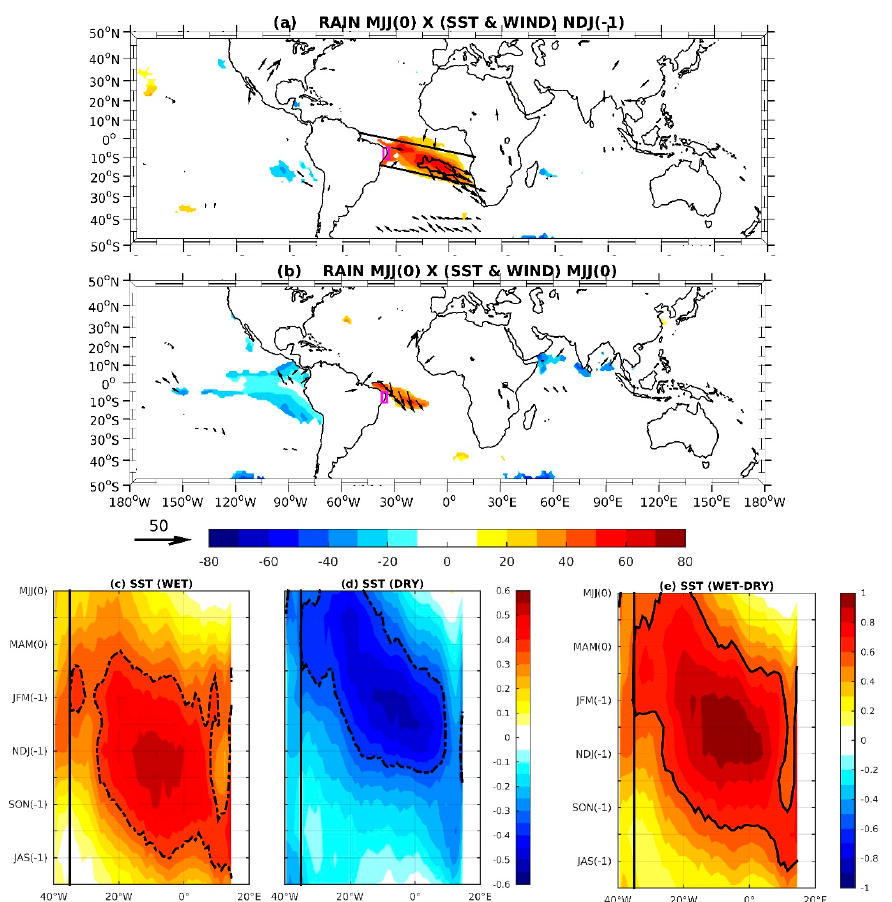
Figure 2. Distributions of the lagged linear correlation/regression (mm month -1 /°C) of the gridded SST (from OAFlux) anomalies in ( a ) November-December-January(-1) (NDJ( − 1)) and ( b ) MJJ(0) with the rainfall anomalies in Eastern NEB (magenta box) during MJJ(0) for the period 1960–2015. The vectors represent the linear regression (mm month − 1 /m s − 1 ) of the surface wind vectors (u and v; from NCEP) anomalies, with the rainfall anomalies in Eastern NEB. The correlations that are significant at the 95% confidence level, according to the t -test, are plotted for both SST and wind. Contours indicate regions of correlation higher than +0.5 (solid black line) for SSTA. The diagonal band in Figure 2a indicates the pathway of the northwestward propagation of SSTA. Longitude–time diagrams of the composites of standardized SSTA for: ( c ) WET years, ( d ) DRY years and ( e ) difference WET–DRY years for the period 1960–2015. The SSTA are averaged along the latitude of the diagonal band in Figure 2a. Contours represent values significant at a 95% confidence level using the t-test. The vertical black lines (at 35° W) in ( b ), ( c ), and ( d ) indicate the eastern limit of the Eastern NEB. The significant positive relationship between the tropical South Atlantic SSTA and the MJJ Eastern NEB rainfall moves westward from NDJ and concentrates only near the NEB coast just before or during the rainy season (Figure 2b). This observation is consistent with results in [38]. The westward displacement of the SSTA relationship is confirmed in Figure 2c,d, in which we show the longitude-time diagram of the WET and DRY composites of standardized SSTA along the diagonal band indicated in Figure 2a. However, the largest values of the positive and negative SSTA linked to WET and DRY events, respectively, in Eastern NEB are not symmetric during the westward propagation. The high positive SSTA linked to WET events in Eastern NEB start early in the eastern